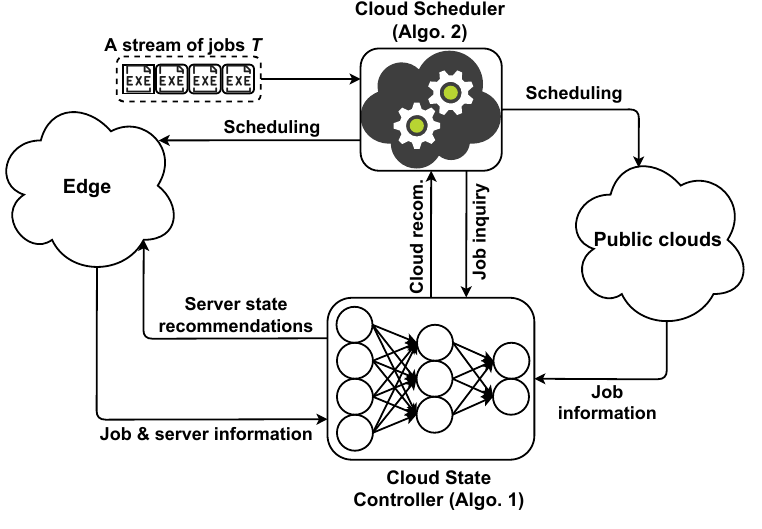
Figure 1. Structure of